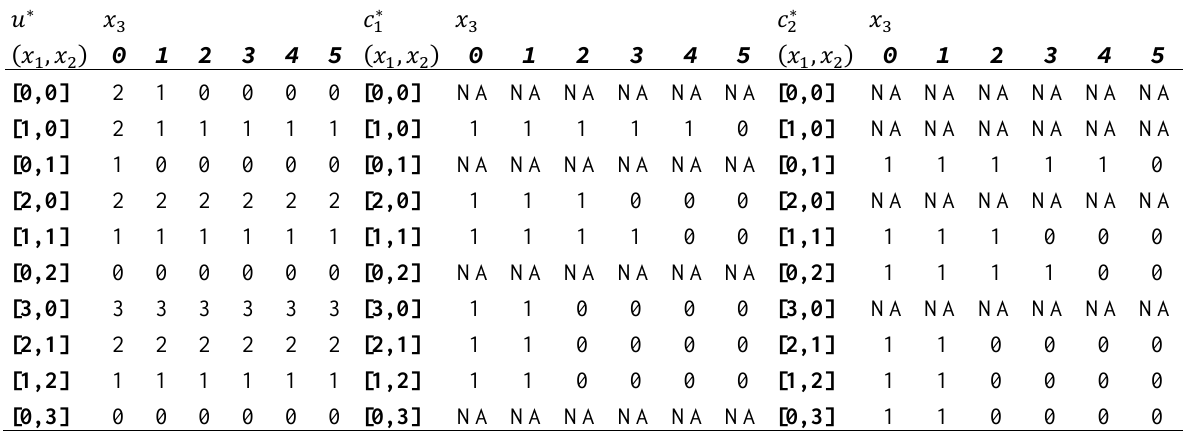
Table 5. Optimal production decisions, s=3 and